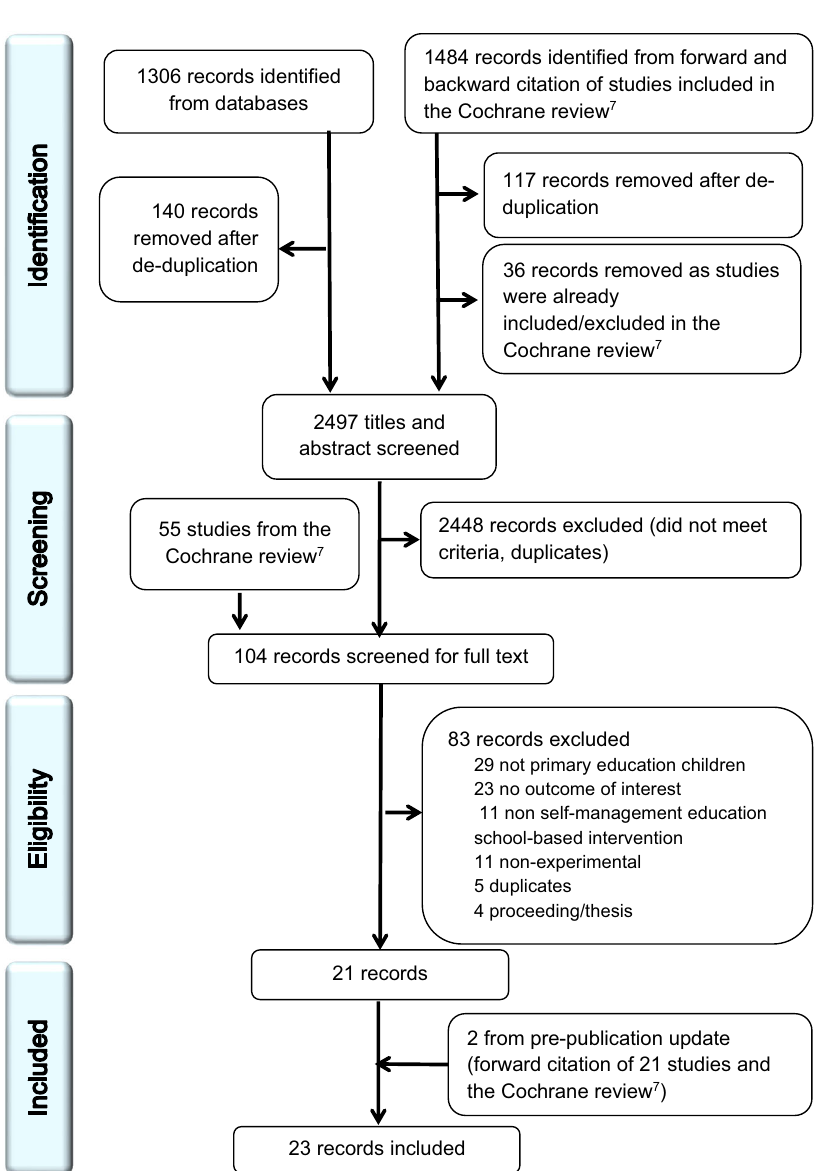
Fig. 1 PRISMA diagram. This fi gure illustrates the article selection process using the PRISMA